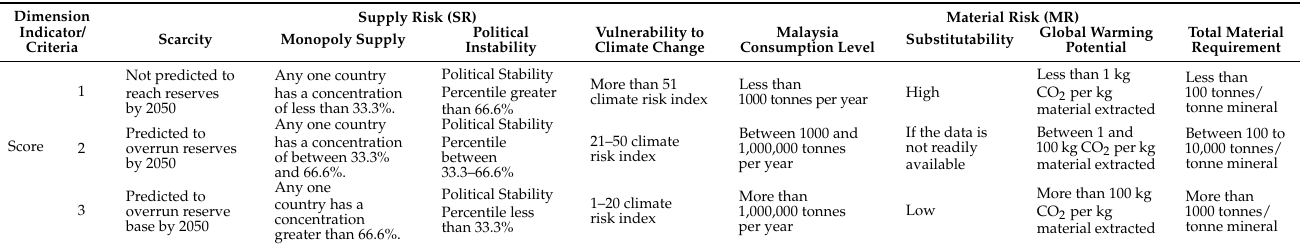
Table 4. Scoring matrix used to determine a material’s criticality